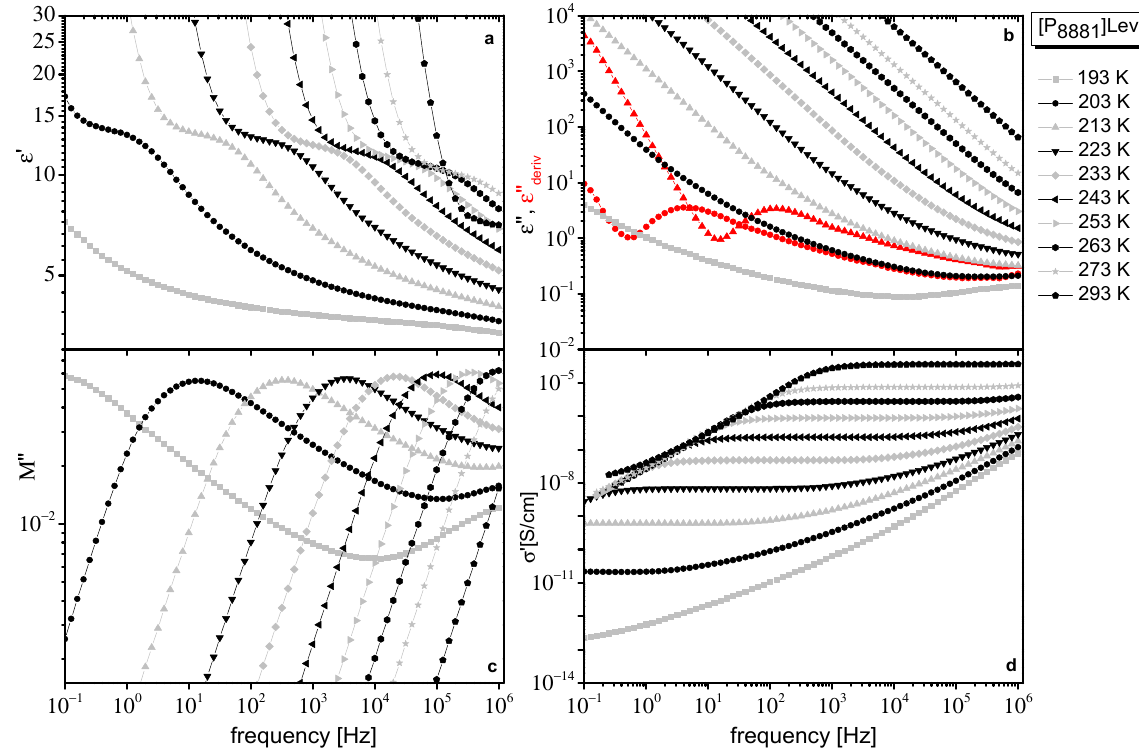
Figure 2. Different representations of dielectric data obtained for [P 8881 ]Lev at the temperatures indi- cated on the plot. Real part of dielectric permittivity ε (cid:48) (f) ( a ), imaginary part of dielectric permittivity, ε″(f) ( b ), derivative of ε′ , ε″ deriv (f) discussed in the text (at two selected temperatures, red symbols in ( b ), imaginary part of electric modulus, M″(f) ( c ) and real part of conductivity, σ′(f) ( d ). In the imaginary part of the electric modulus, M” (M ∗ ( f ) = M (cid:48) ( f ) + iM (cid:48)(cid:48) ( f ) = 1/ ε ∗ ( f )